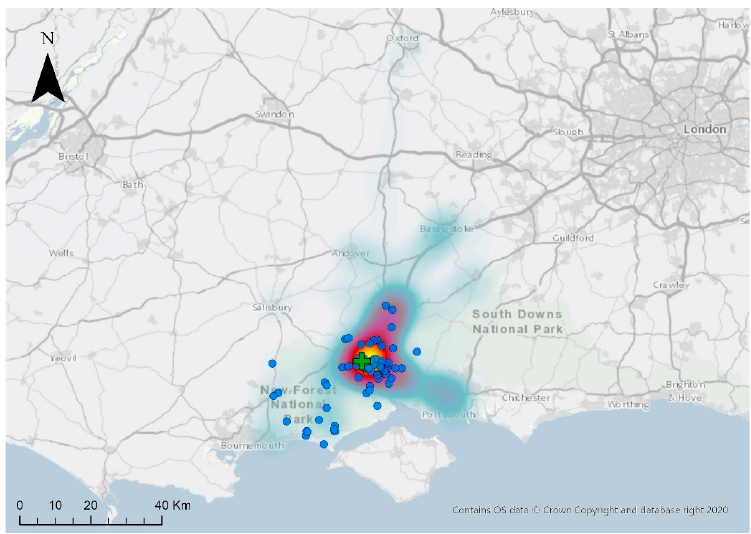
Figure 6. Map showing movements of all PTS vehicles during an example day (4 March 2021) in the BAU scenario. Heat map shows intensity of vehicle movements, blue circles show locations of GP surgeries and green cross shows the location of SGH.